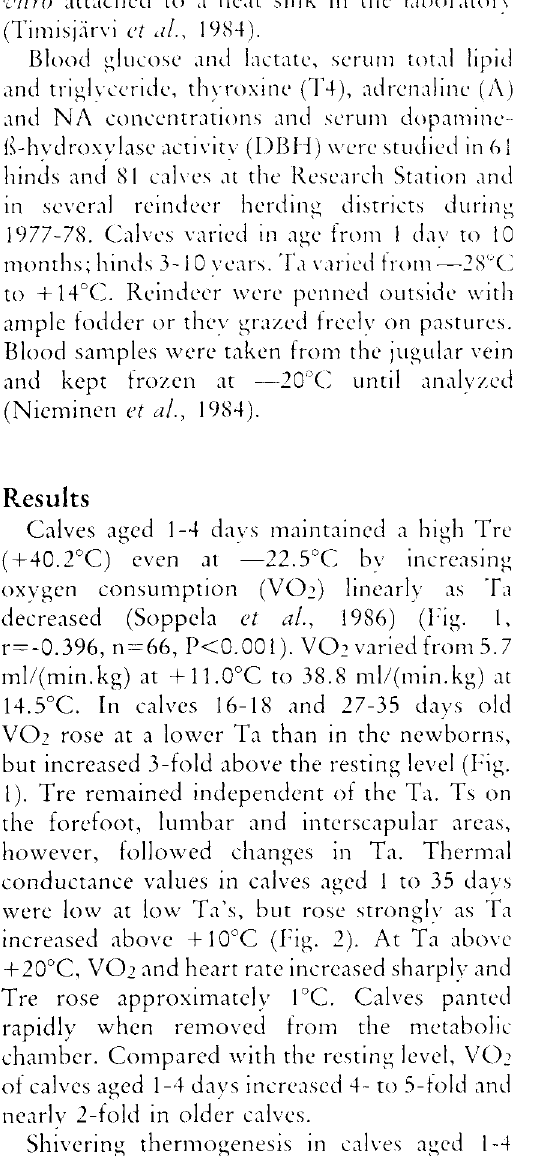
Fig. 1. Relation of oxygen consumption